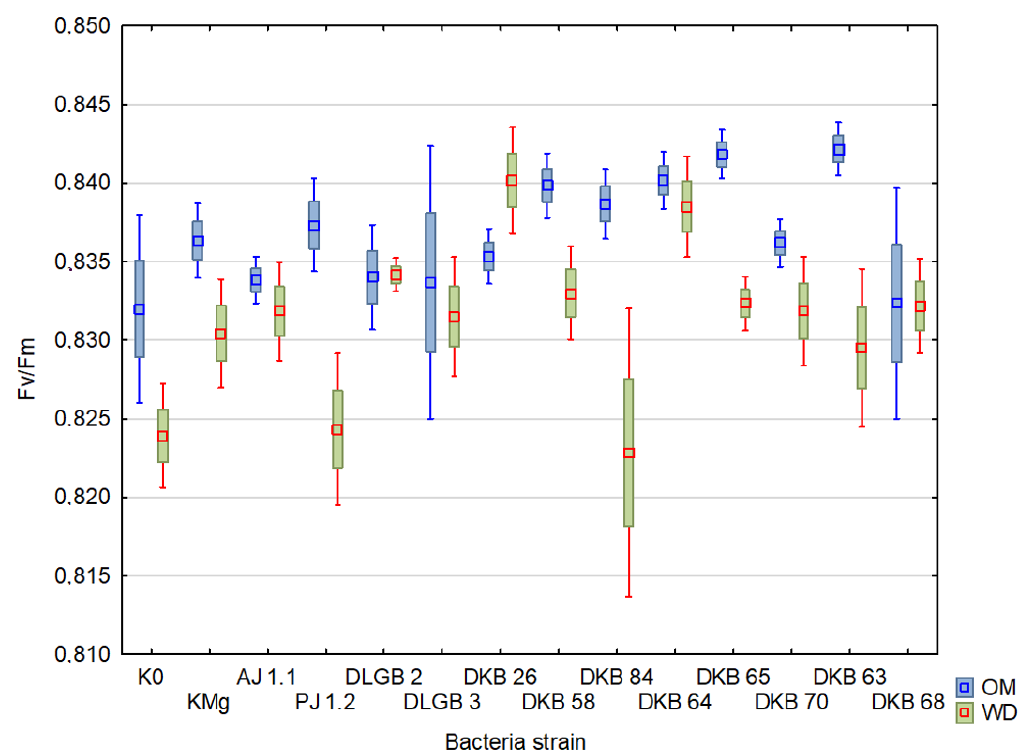
Figure 7. F V /F M in the leaves of strawberry plants inoculated with rhizosphere bacteria growing under different substrate moisture levels, where: OM — optimal moisture, WD — water deficit.